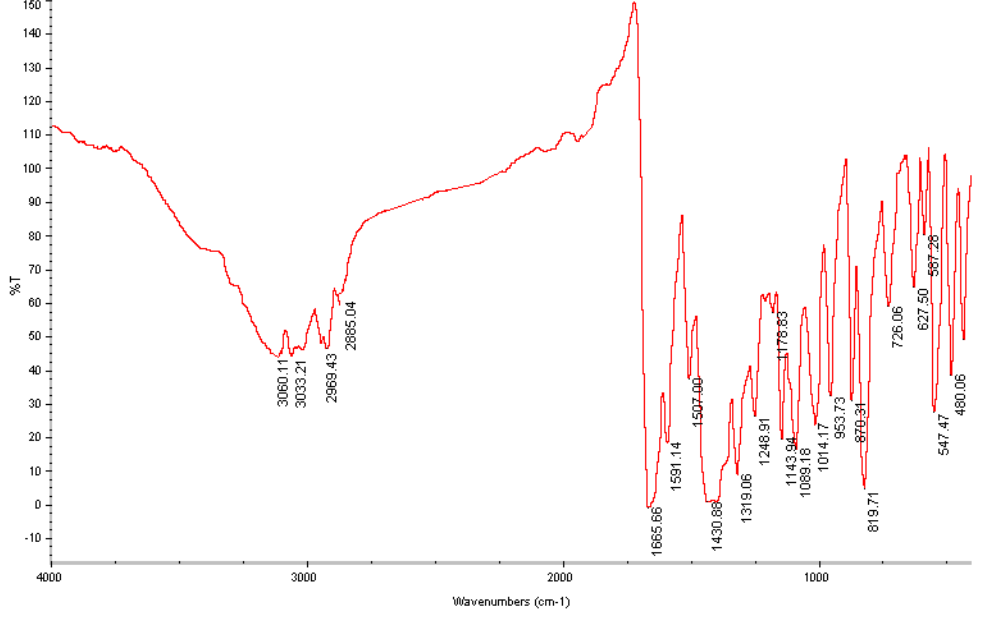
Figure 3. Experimental IR spectrum of the title compound.